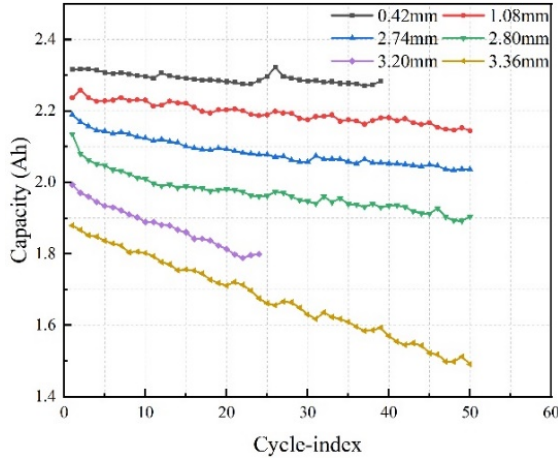
Figure 7. Capacity decay curves of batteries with 6 different residual deformations.